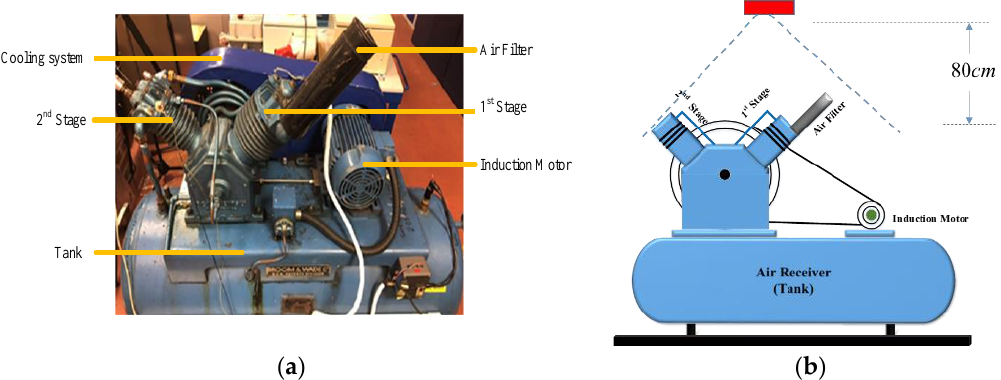
Figure 1. Experiment facilities: ( a ) test rig; ( b ) the positional relationship between the infrared camera and the reciprocating compressor.